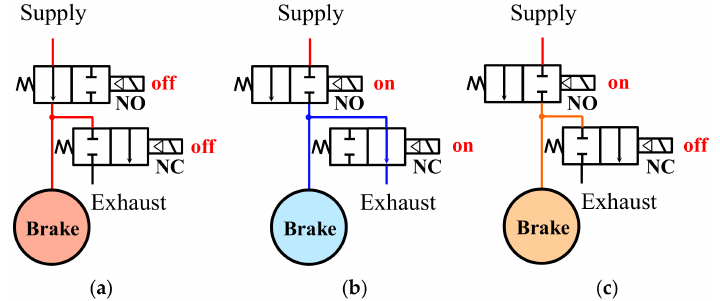
Figure 4. Pressure modulation modes of the ( a ) apply mode; ( b ) dump mode; and ( c ) hold mode.